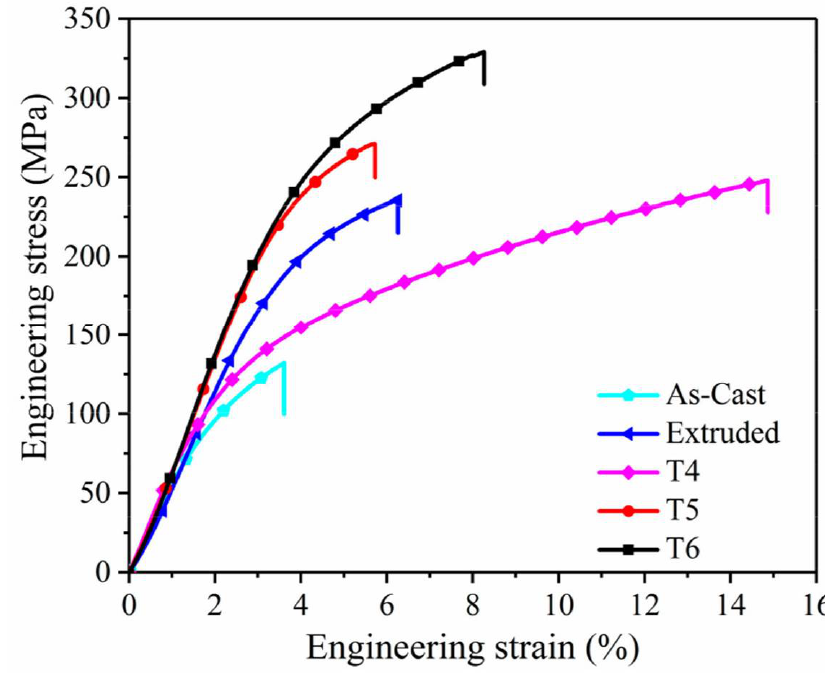
Figure 6. Stress vs strain graph of AZ80 alloy with different processing techniques [45].